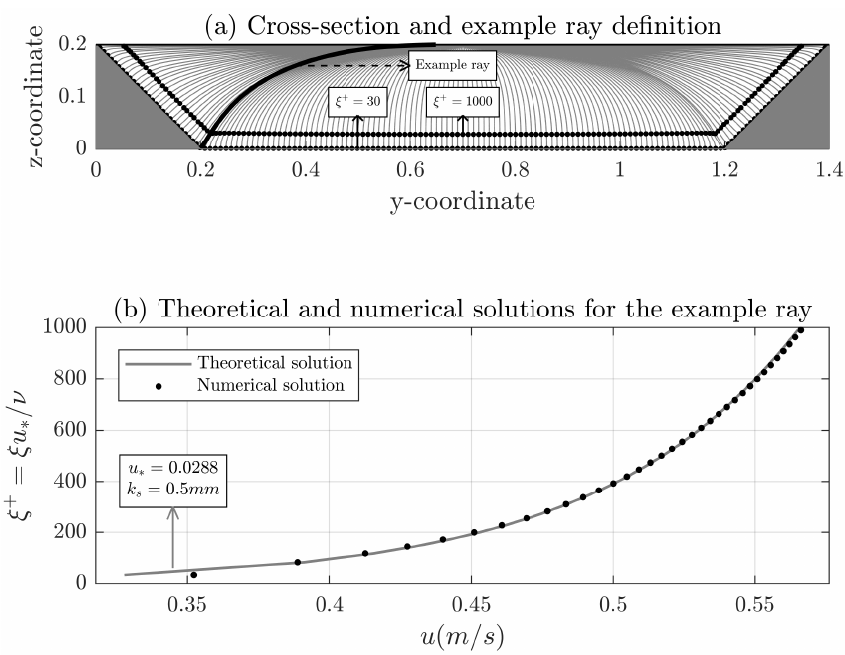
Figure 4. ( a ) Rays for the solution of a trapezoidal section and definition of the example ray; and ( b ) theoretical ( u ∗ = 0.0288; k s = 0.5 mm) and numerical solution for the example ray velocity profile in the fitting